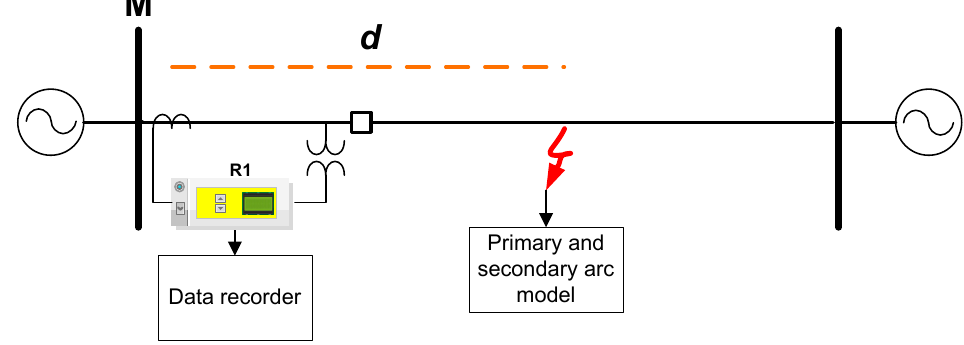
Figure 3. Electric power system used.